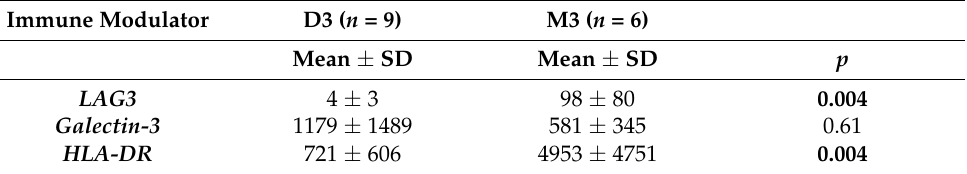
Table 2. Mean mRNA expression levels of different immune modulators defined by qPCR in UM